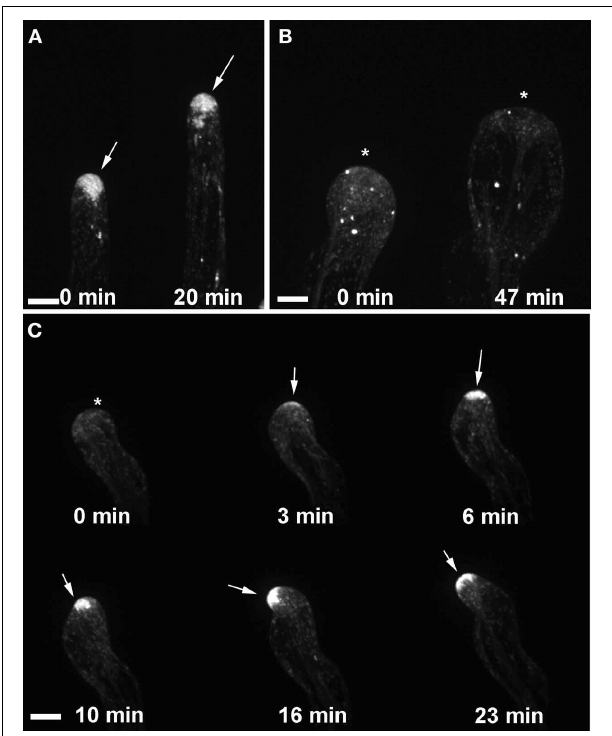
FIGURE 4 | Targeting of RABA4b secretory vesicles to the root hair tip is disrupted in ark1 . (A) EYFP-RABA4b is preferentially enriched at the tips of wild-type seedlings during root hair elongation (arrows). (B) In ark1 root hairs, there is no enrichment of the EYFP-RABA4b signal in a swelling root hair (asterisks). (C) In a waving root hair, the EYFP-RABA4b signal often dissipates (asterisk) but eventually reforms when tip growth resumes (arrows). The EYFP-RABA4b typically follows the change in root hair growth direction. Time-lapse movie sequences of corresponding still images are presented as Movies S1 (for wild-type), S2 , and S3 (for ark1 ). Bars = 20 μ